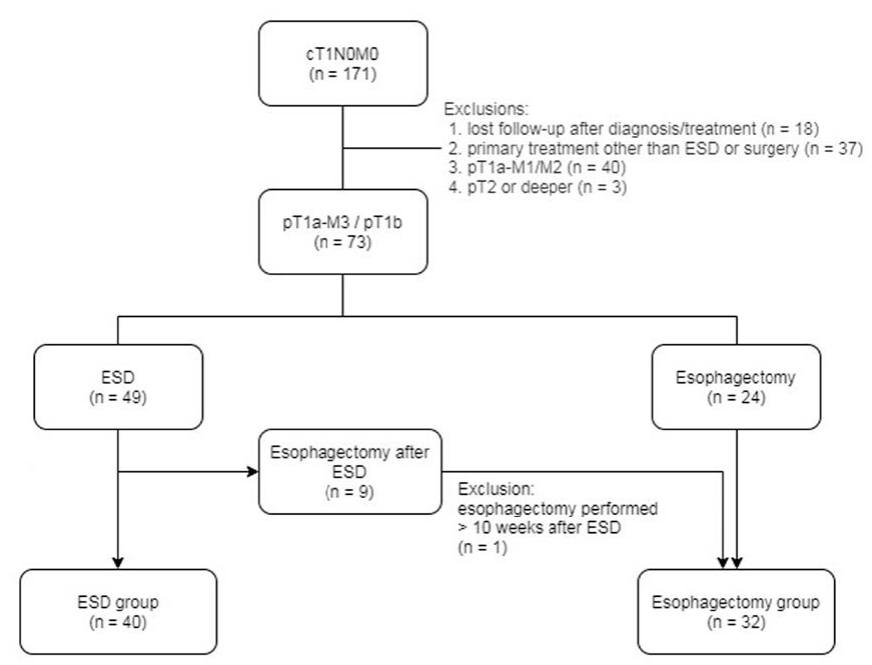
Figure 1. Flowchart of the study. Abbreviations: ESD: endoscopic submucosal dissection.